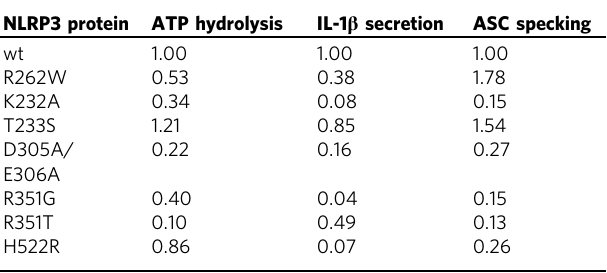
Table 2 Correlation of ATP hydrolysis with downstream signaling.